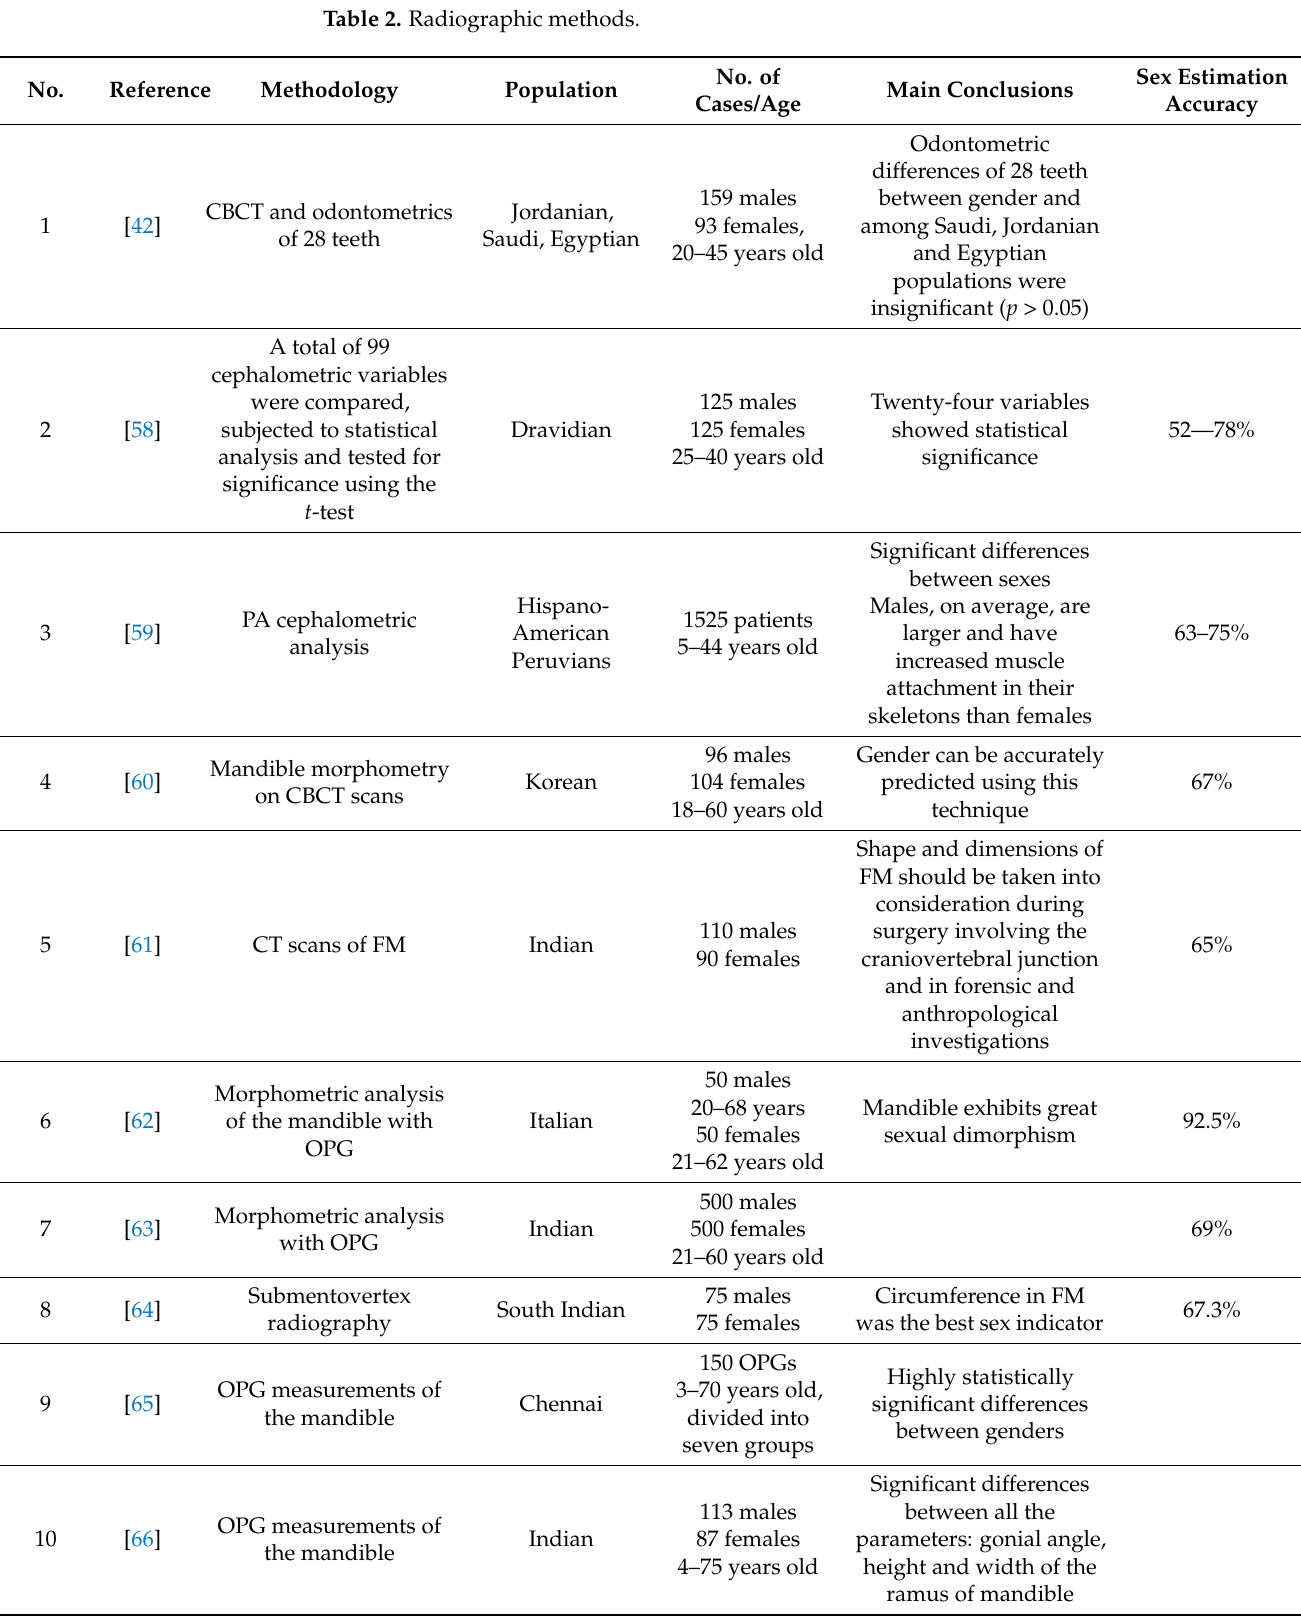
Table 2. Radiographic